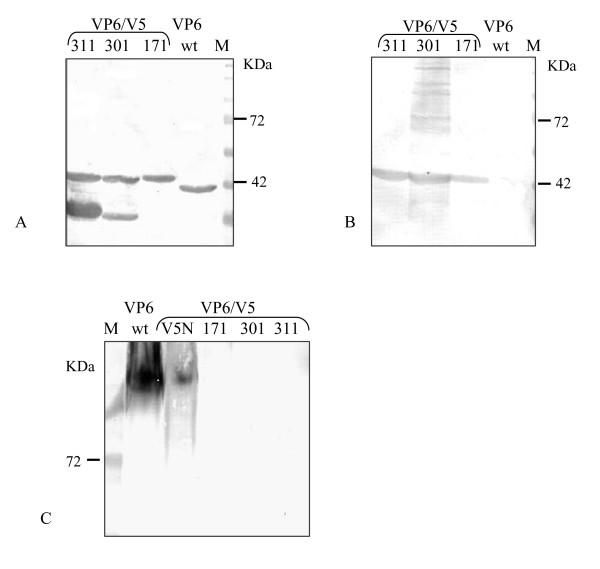
Expression of chimeric VP6/V5 protein. Sf9 cells infected with baculovirus AcVP6, AcVP6171/V5, AcVP6301/V5 or AcVP6311/V5, were analyzed by western blot using a polyclonal sera anti-VP6 (A) or a MAb anti-V5 epitope (B). In order to determine the trimerization ability of the chimeric VP6/V5, cells extracts were analyzed by electrophoresis under native conditions and western blot (C).